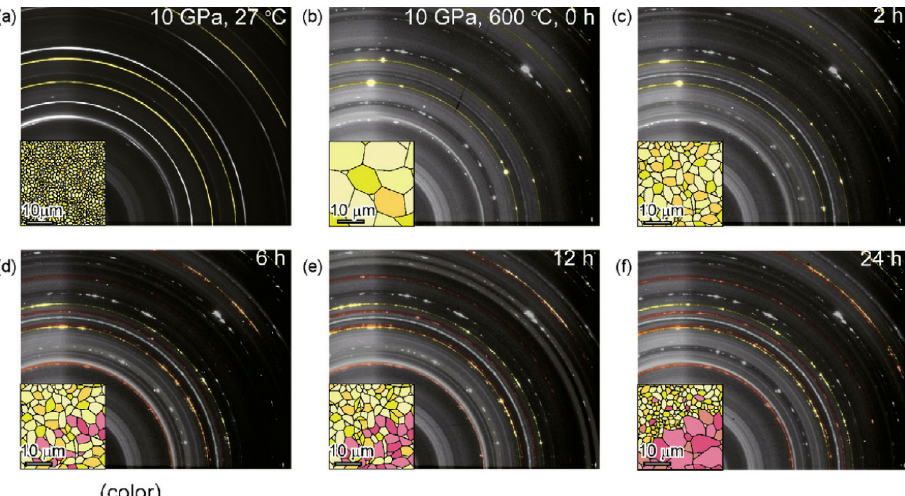
Figure 5. X ‐ ray diffraction images of the sample during the hydrogenation. ( a ) Complete Debye rings from aluminum at 10 GPa, 27 °C. ( b ) Bragg spots from aggregated aluminum (colored in yellow). This image was taken immediately after the sample was heated to 600 °C at 10 GPa. ( c – f ) Diffraction images taken after 2 h, 6 h, 12 h, and 24 h heat treatment at 10 GPa, 600 °C. Reprinted with permission from ref. [44]. Copyright 2010 Elsevier.